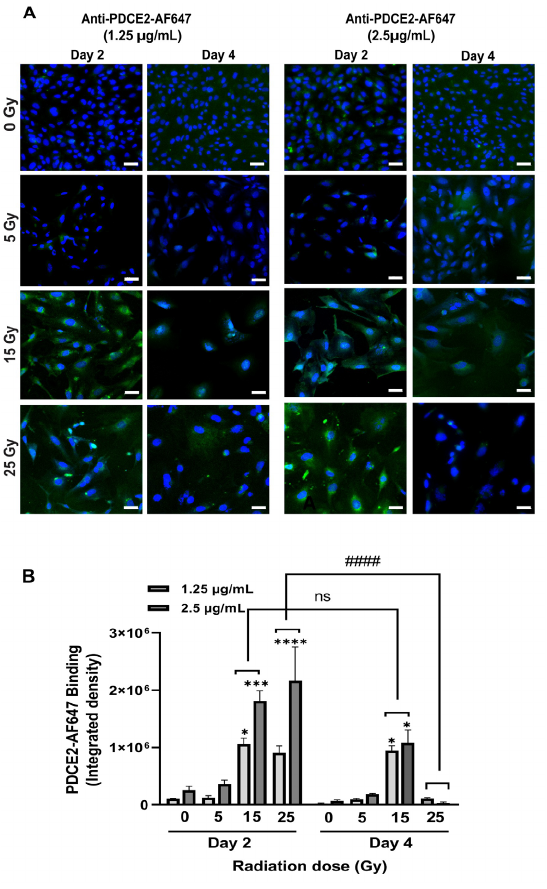
Figure 2. Anti-PDCE2 antibodies bind to the surface of irradiated endothelial cells under optimized shear flow in a parallel-plate flow system. ( A ) Confocal images demonstrate binding of fluorescently tagged PDCE2 antibody (AF-647, green) at two different concentrations (1.25–2.5 µ g/mL) to the irradiated cell surface at day 2 and day 4 post-irradiation (0–25 Gy) after 15 min of circulation in growth medium in the parallel-plate flow system. Nuclei were stained with DAPI (blue). Magnifica- tion 200 × (Bar = 50 µ m). ( B ) Confocal images from three independent experiments were analyzed using NIH Image J. Data (integrated density) are shown as mean ± SEM and were analyzed using two-way ANOVA followed by Tukey’s post-hoc analysis. * p < 0.05, *** p < 0.001, **** p < 0.0001, compared to corresponding non-irradiated cells. #### p < 0.0001, comparison between timepoints. ns, not